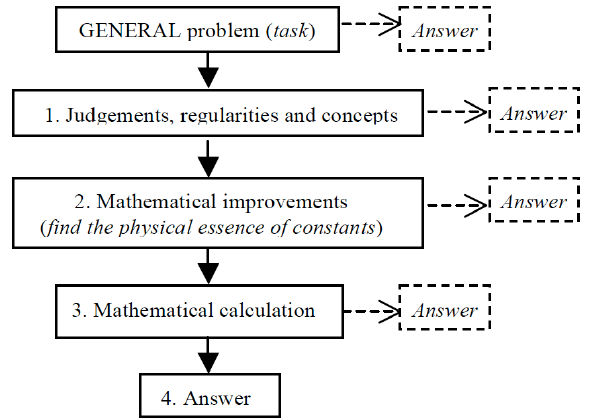
Figure 4. Frameworks for organization of general problem solving in mathematics